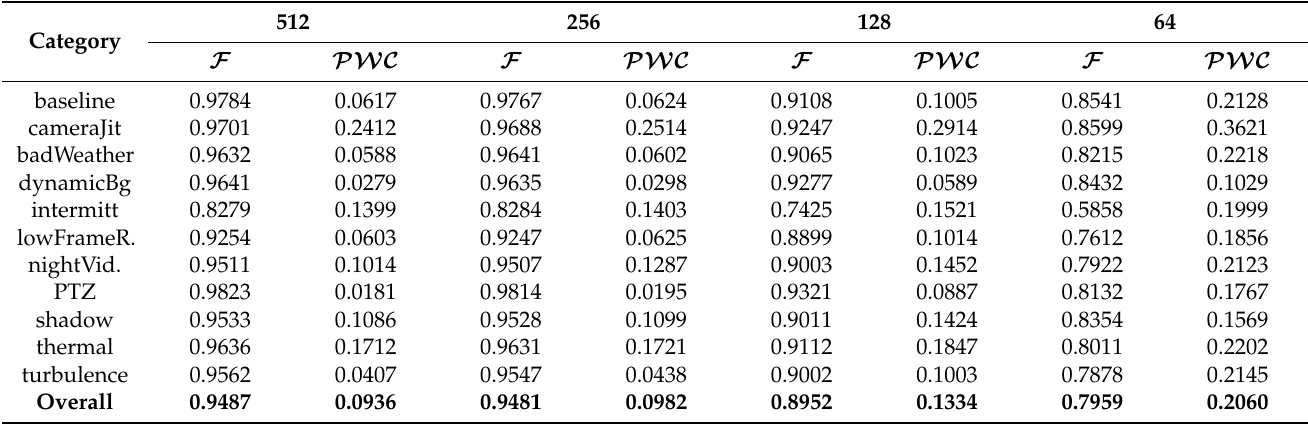
Table 4. Experimental results of channel reduction factor ablation for our single linear bottleneck. The last row represents the average result for each scenario.